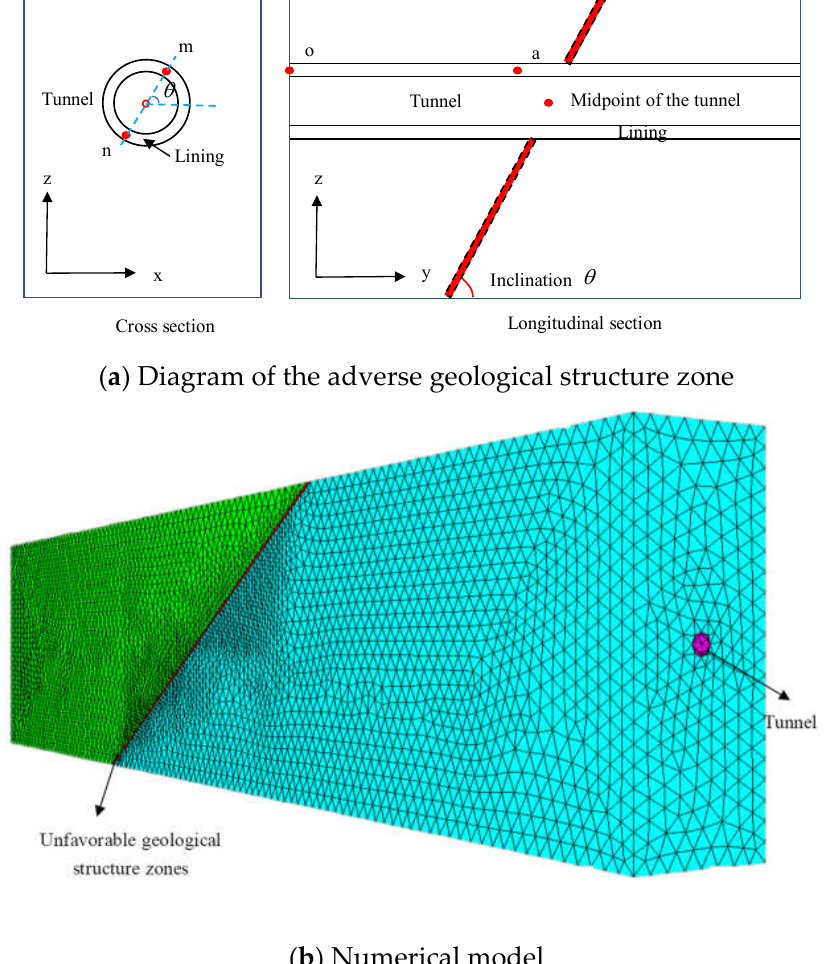
Figure 1. Adverse geological structure zone and numerical model of the tunnel. Table 1. Parameters of materials.